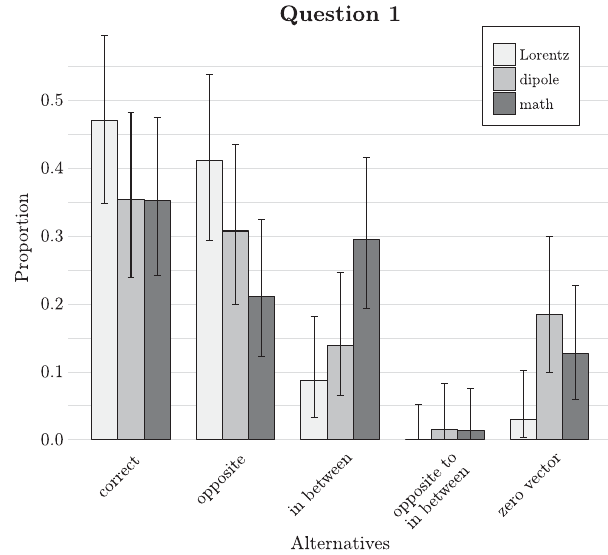
FIG. 3. Students ’ answers on question 1 about the cross product of two orthogonal vectors. Error bars indicate the 95% confidence intervals based on the Clopper-Pearson method [22].